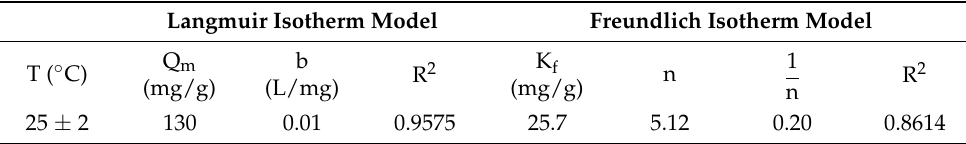
Table 3. Langmuir and Freundlich parameters for AB 113 adsorption onto IRA 402 mass.